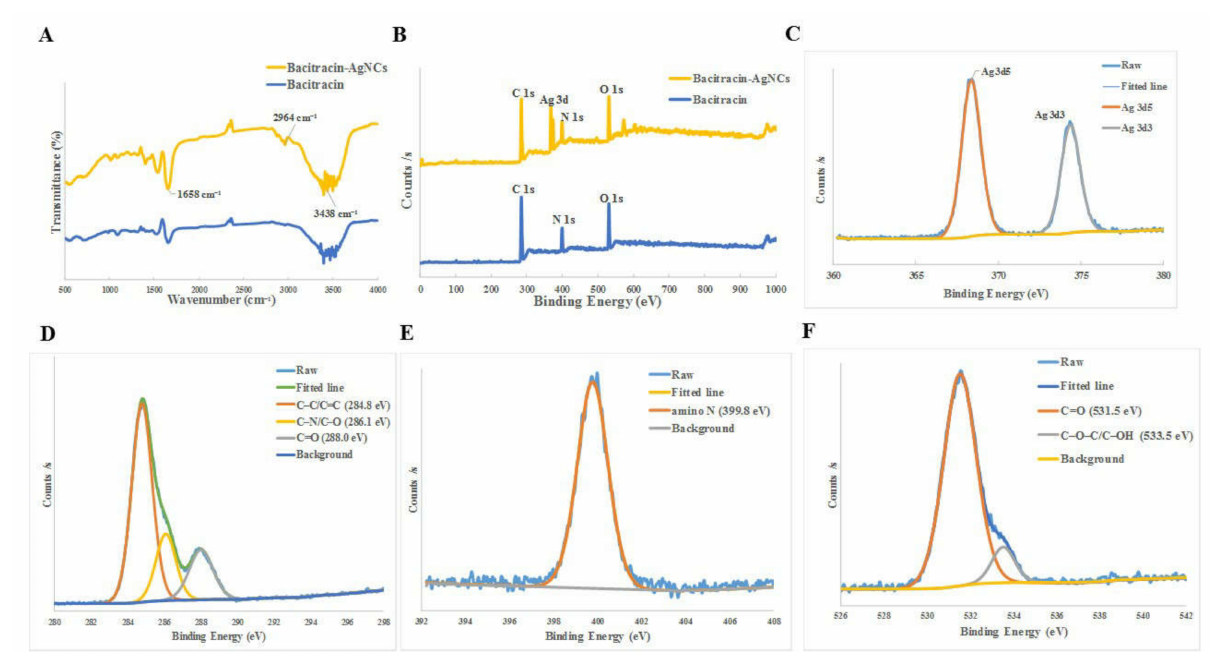
Figure 2. ( A ) FTIR spectrums of bacitracin and Bacitracin-AgNCs. ( B ) XPS full scan survey of bacitracin and Bacitracin- AgNCs. ( C ) Binding energy spectra of Ag 3d. ( D – F ) High-resolution spectra of C 1s, N 1s and O